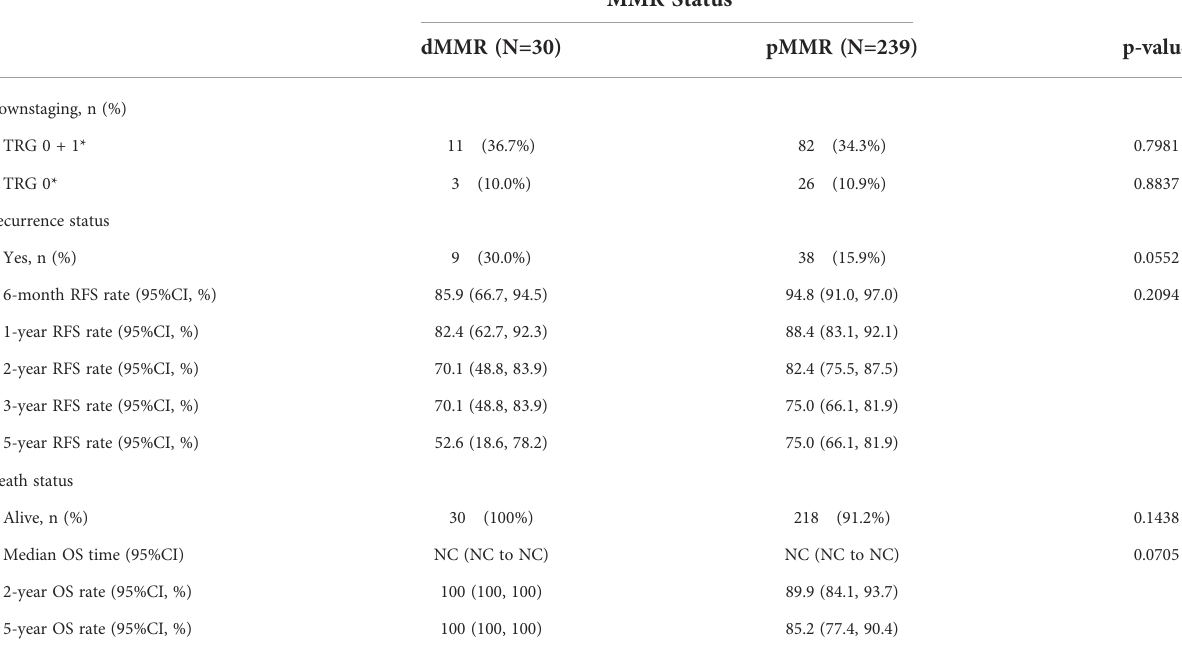
TABLE 2 Downstaging, recurrence and overall survival endpoints of the 269 MMR patients.